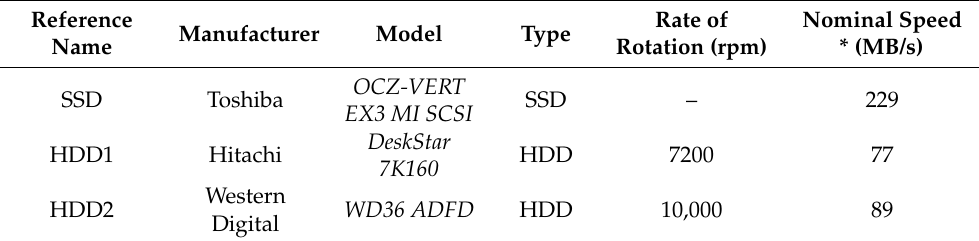
Table 2. Employed hard drives and relevant characteristics (*, assessed in a quiet room using HDSpeed